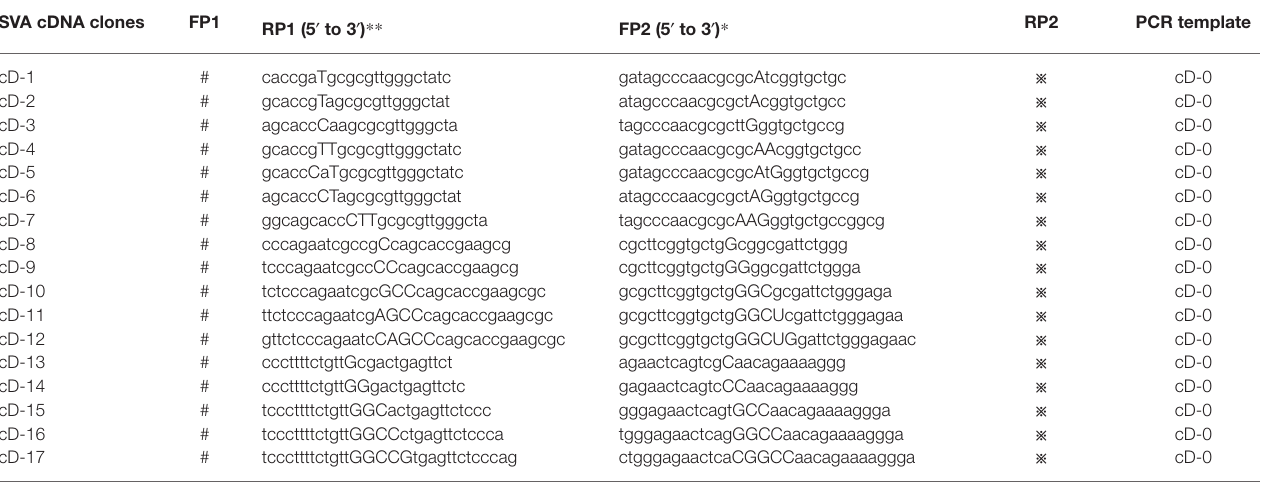
TABLE 1 | Primers used to construct SVA cDNA clones with point mutations by overlap extension PCR. SVA cDNA